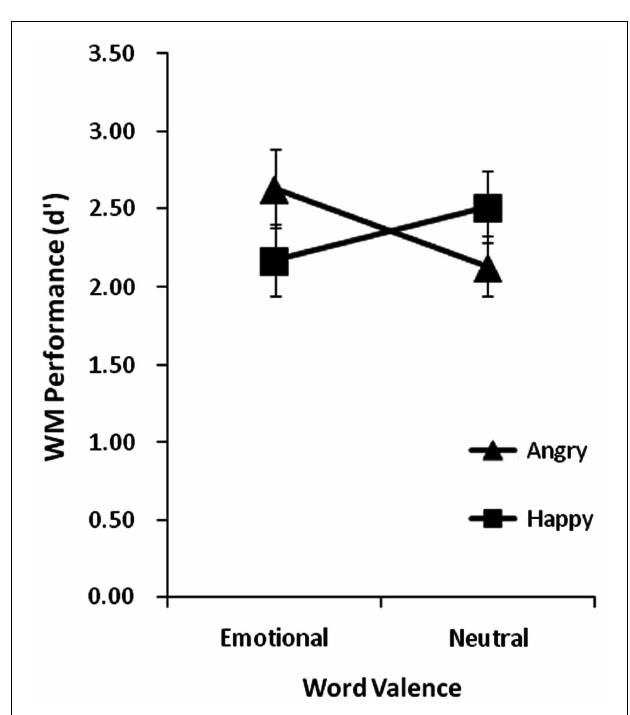
FIGURE 3 | Group meanWM performance measured in d (cid:48) when allWM memoranda faces had happy or angry expressions and the incidental words presented during the retention interval were negative, positive, or neutral. Vertical lines represent ± 1 SE.